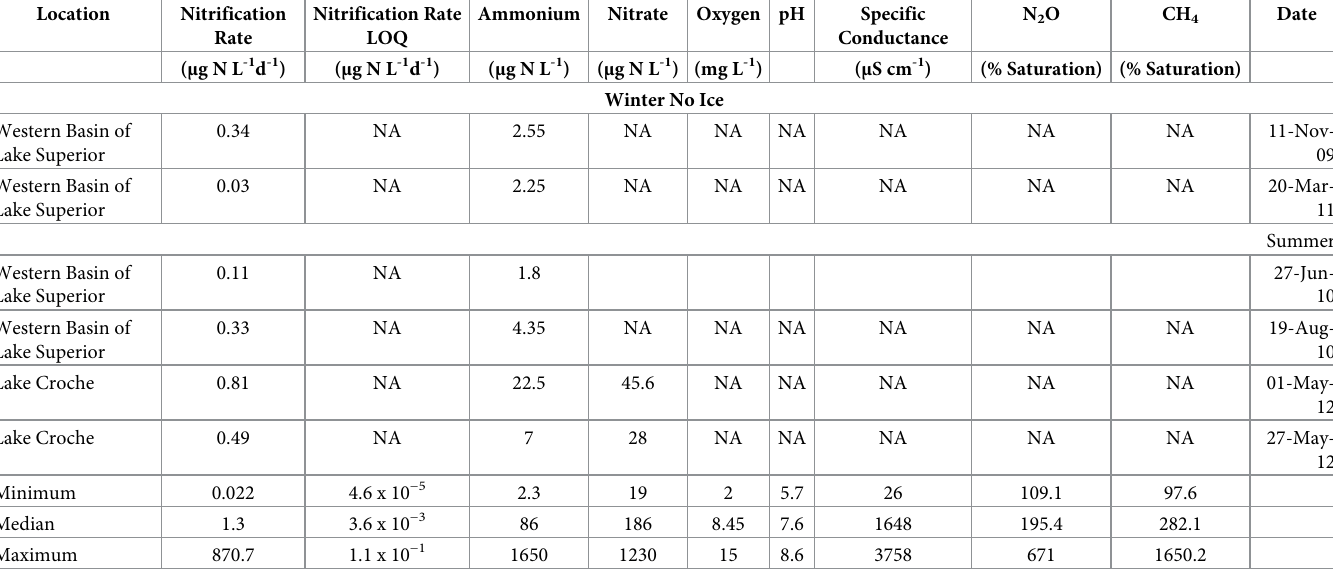
Table 2. Winter nitrification rates and associated data for Lake Superior (near surface at 2 m depth, in winter but without ice-cover; [40]). Summer values of nitrifi- cation rates are reported for the two lakes (Western Basin of Lake Superior and Lake Croche) where cross-season study has been performed. Values below limits of quanti- tation (LOQ) for nitrification rates are reported, including negative values (following [40]) and sample-specific LOQ (as described in Methods and calculated as per [43,44])are